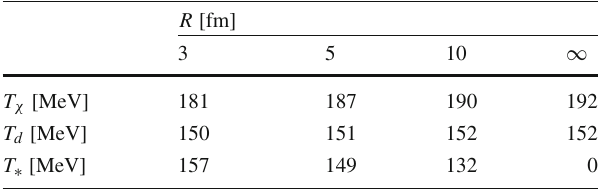
Table 2 Same as in Table 1 but for the logarithmic Polyakov loop potential